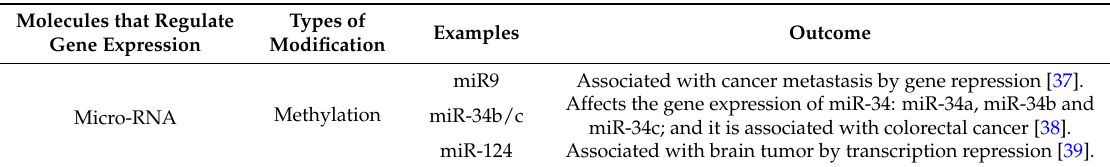
Table 2. Epigenetic regulations of gene expression by micro-RNAs. Description of the effects of methylated mRNAs that are associated with gene repression.